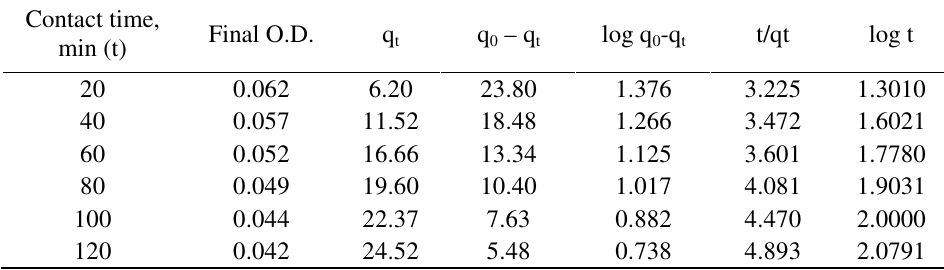
) = 30 ppm; O.D. for initial dye 0 ) = 0.007; q – q = 30.00-0.007 = 29.993) e 0 e